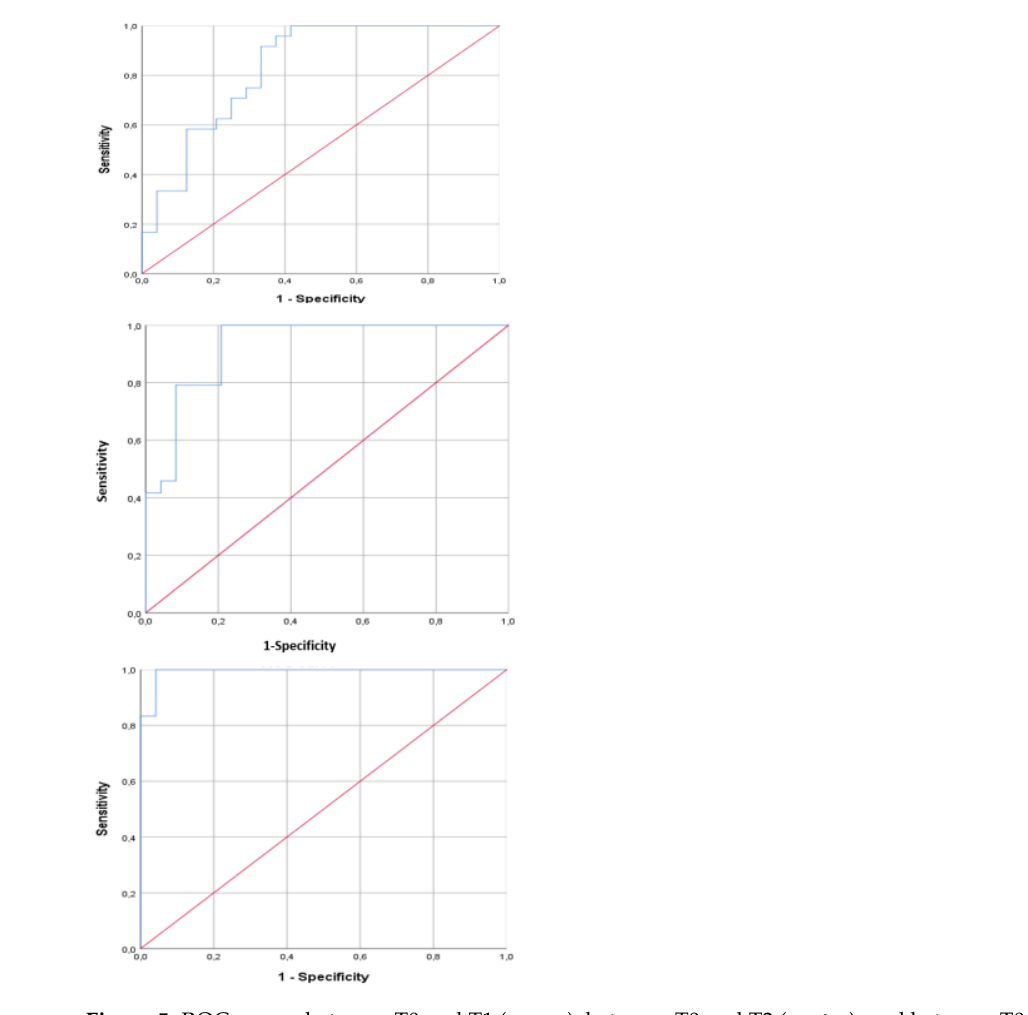
Figure 5. ROC curves between T0 and T1 (upper), between T0 and T2 (center), and between T0 and T3 (lower).